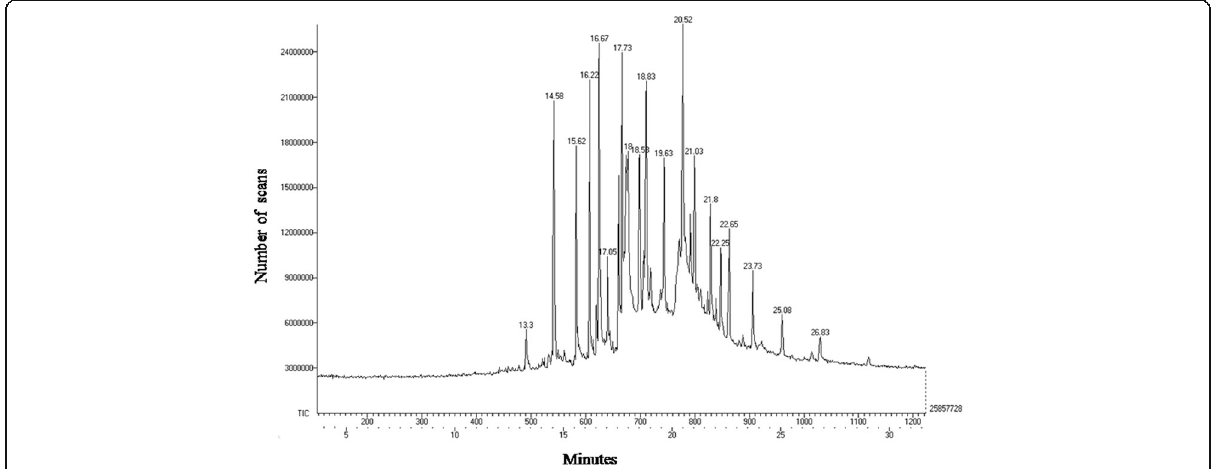
Fig. 2 GC-MS profile of GAE. The GC-MS analysis revealed the presence of various compounds with differing retention time